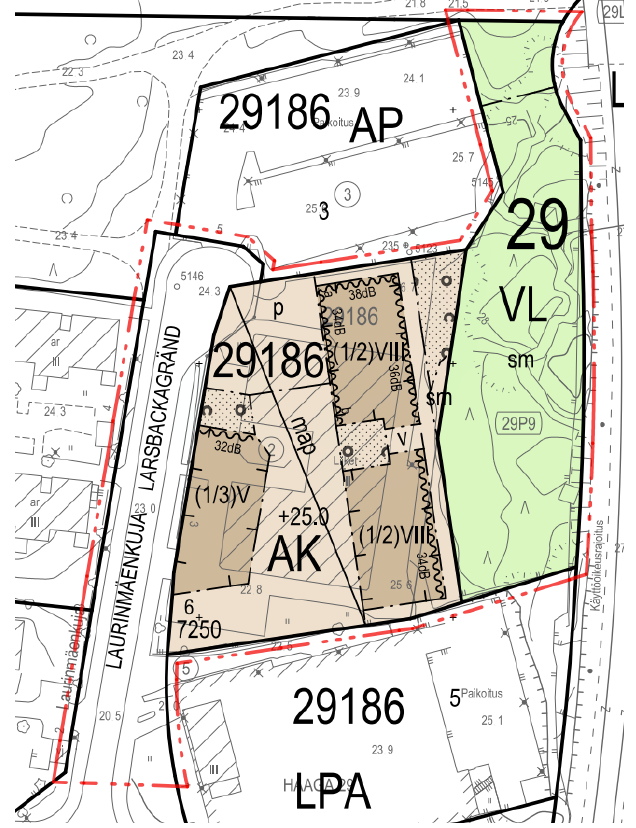
Figure 1. The selected plot of the land at Laurinmäenkuja 3 in Lassila, Helsinki.